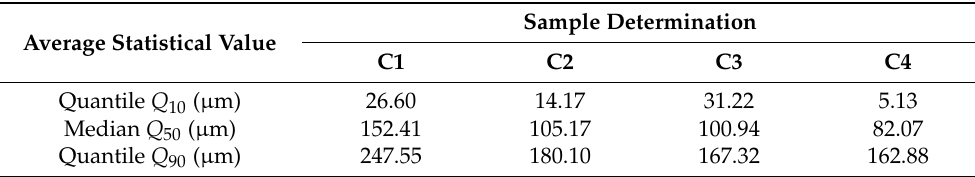
Table 6. Statistical mean values of the particle size distribution of the powders used for surfacing (PPTAW) of composite layers.